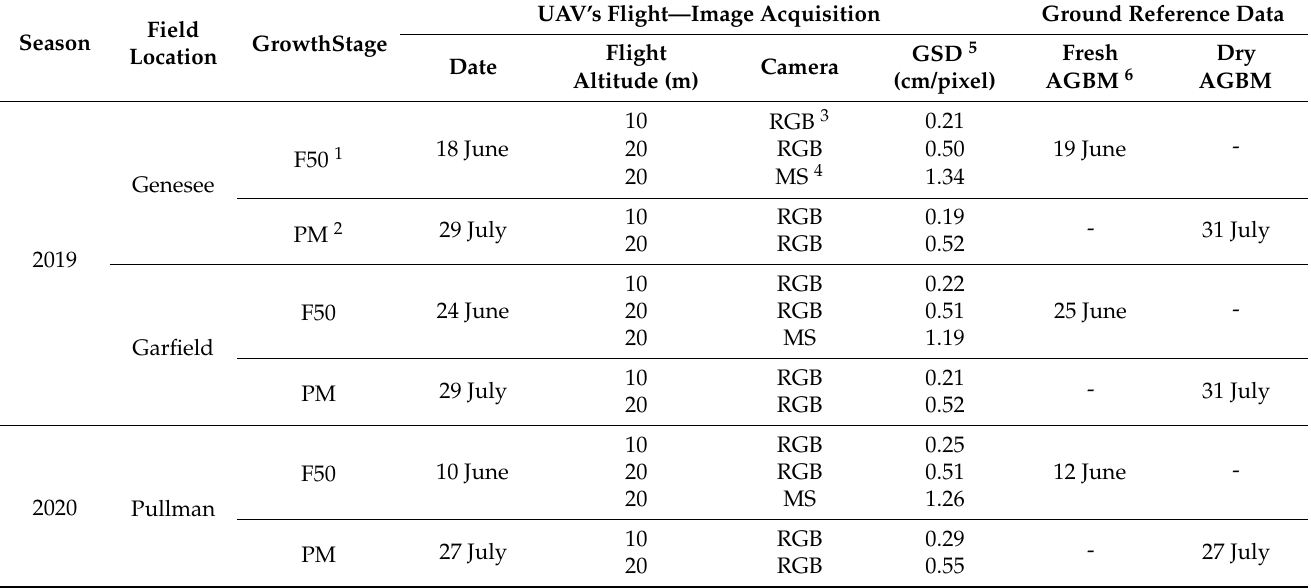
Table 1. Summary of the raw data acquired in this